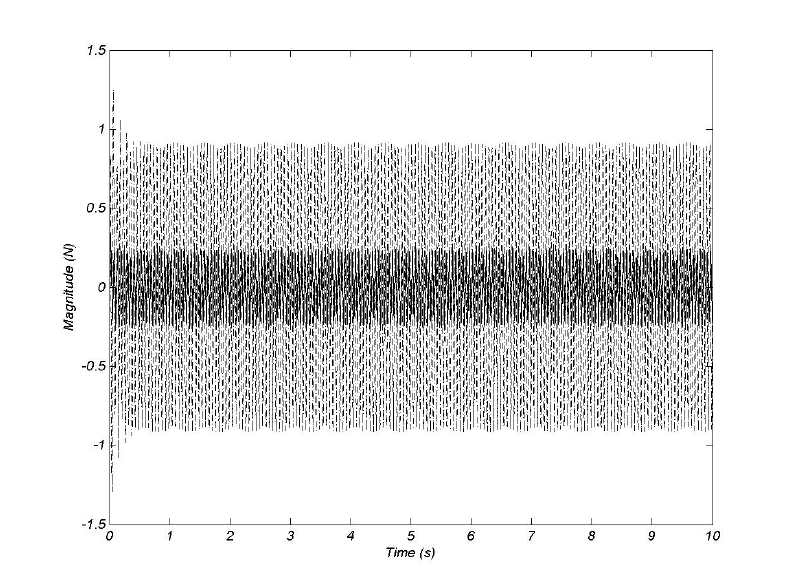
Fig. 22. Transmitted force variations of the system using the PID controller subjected to periodic engine disturbance at idling frequency. Open loop (–) and PD controlled (solid).